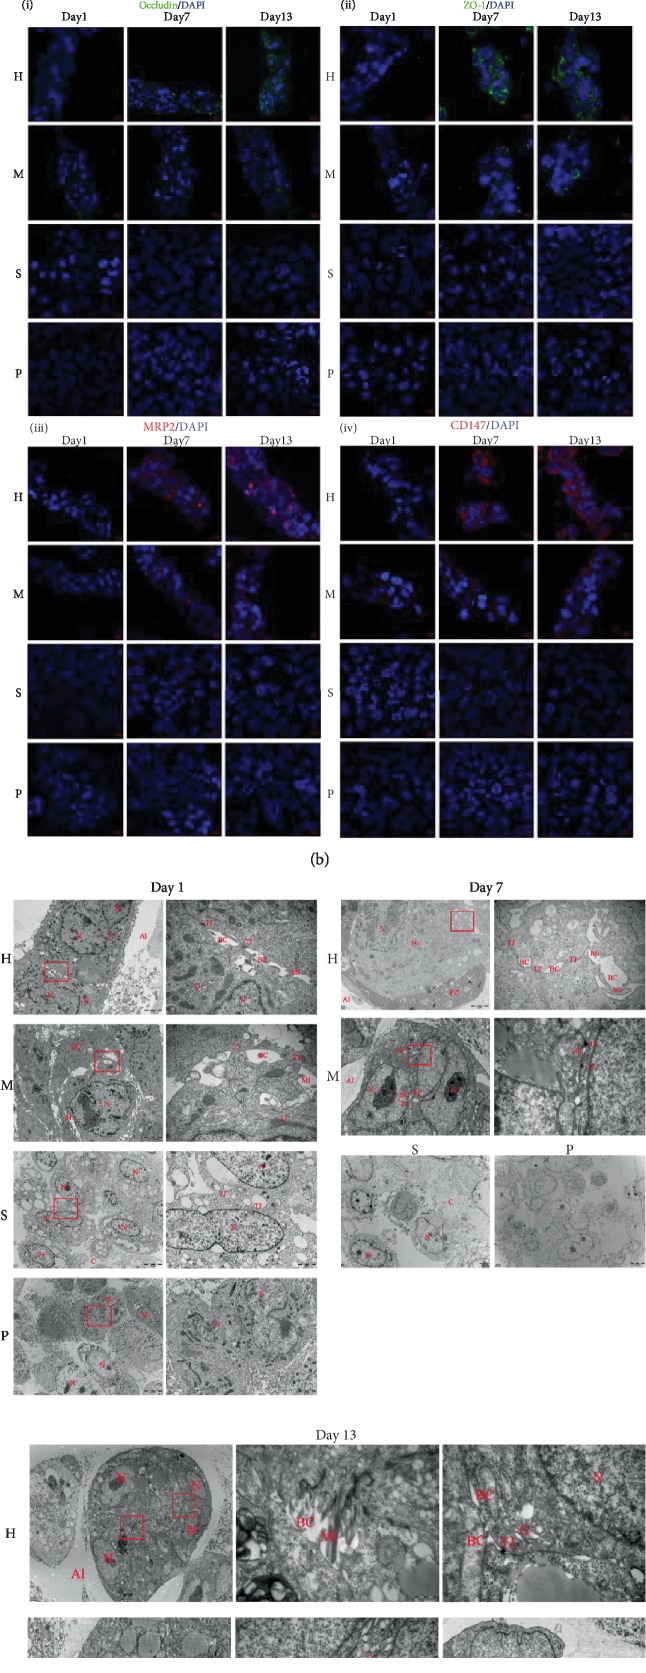
Comparison of hepatocyte polarity. (a) Comparison of gene expression levels of hepatocyte structural polarity proteins. The data are presented as the mean ± SD. Two-way ANOVA: comparison between H and other groups: ∗P < 0.05, ∗∗P < 0.01, ∗∗∗P < 0.001. (b) Immunofluorescence staining of hepatocyte polarity proteins: staining of occludin (occludin: green; cell nucleus: blue) (i), staining of ZO-1 (ZO-1: green; cell nucleus: blue) (ii), staining of MRP2 (MRP2: red; cell nucleus: blue) (iii); staining of CD147 (CD147: red; cell nucleus: blue) (iv). All scale bars: 10 μm. (c) Comparison of cultured hepatocyte ultrastructure: red rectangles represent magnified sites of every group at various time points, with the corresponding magnified images to the right of the original image. Red letters represent the following: H: hepatocyte; EC: endothelial cell; A1: alginate hydrogel; C: collagen; N: cell nucleus; BC: bile canaliculi; TJ: tight junction; Mi: microvilli; G: Golgi bodies; P: phagosome; AP: autophagosome. Scale bar: the scale bars for the low-magnification images of Groups H and M on days 1, 7, and 13 represent 2 μm. The scale bar for high-magnification images is 500 nm, except for the right image in M13, where the scale bar is 2 μm. The scale bars for the left images for Groups S and P on day 1 are 5 μm. The scale bars for the right images for Groups S and P on day 1 are 2 μm. The scale bar for panel S7 is 2 μm. The scale bars for P7, S13, and P13 are 5 μm. H: hepatic plate-mimetic group; M: mixed 3D group; S: sandwich group; P: mixed 2D/plate group.